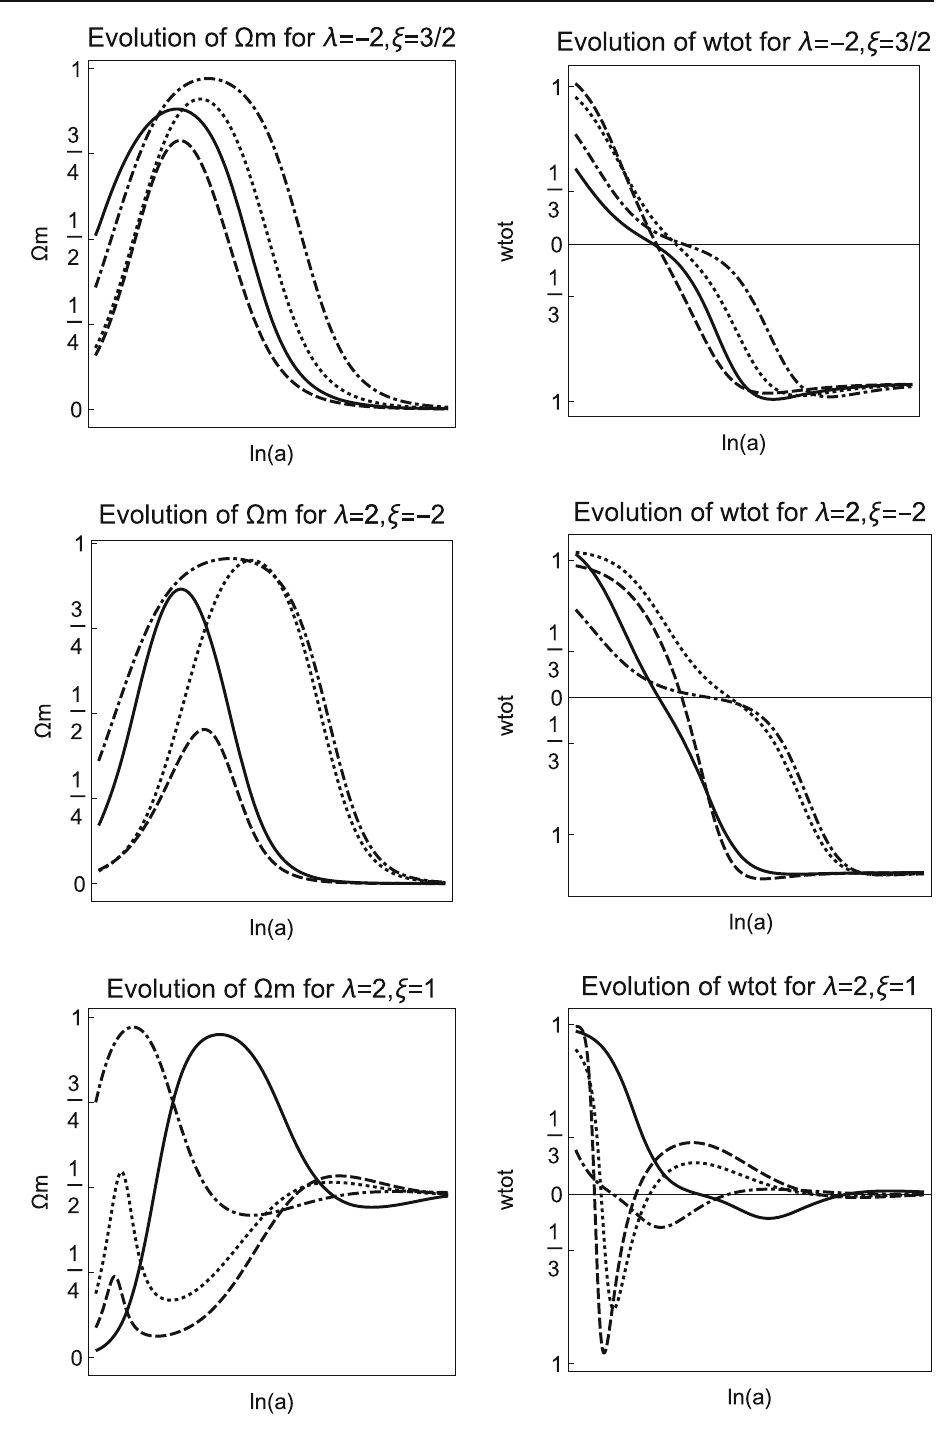
Fig. 8 Qualitative evolution of the energy density (cid:13) m and of the parameter of the equation of state for the effective fluid for the real trajectories presented in Fig.